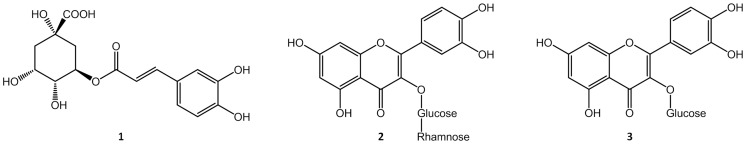
Structures of chlorogenic acid (1), rutin (2) and isoquercitrin (3).